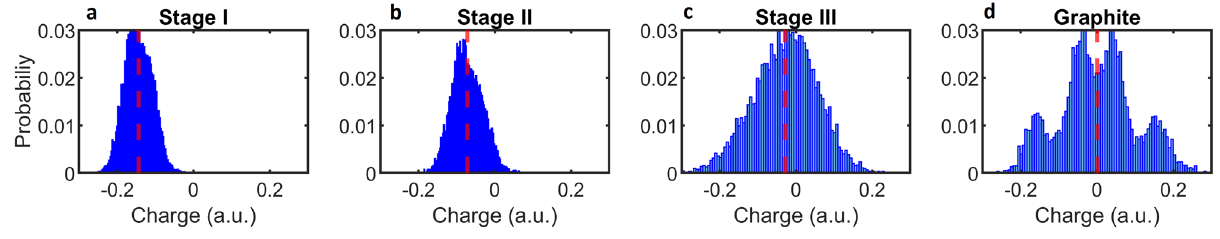
Fig. 3 | Analysis of the Li-GICs charge fl uctuations. a Distribution of C atom charge inLiC 6 , dueprimarily tocharge transferand anharmonicLi-iondynamicsin